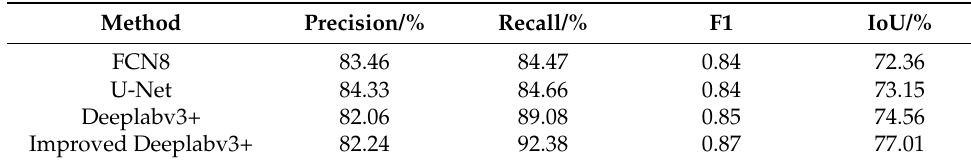
Table 4. Accuracy comparison of semantic segmentation